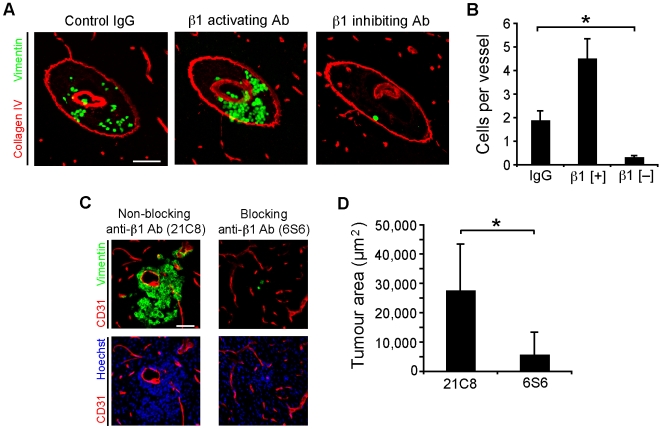
Adhesion to vascular basement membrane requires β1 integrin function.(A) MDA-MB-231 cells were tested for adhesion on slide-mounted human brain slices. Cells were plated in the presence of the indicated antibody and then washed after 2 h. Micrographs demonstrate adherent MDA-MB-231 cells (green) upon the same arteriole (red) in serial human brain sections under different treatment conditions (as indicated). Scale bar, 120 µm. (B) Adhesion to vessels was significantly attenuated with anti-β1 function blocking antibodies (*P<0.001, Kruskal-Wallis test with post-hoc Dunn's multiple comparisons test, tissue from 2 patients run in duplicate and repeated) and potentiated with an activating anti-β1 antibody. (C) MDA-MB-231 cells (vimentin+, green) were treated with β1 integrin subunit blocking or non-blocking antibodies prior to intraparenchymal injection in the brain of SCID mice. After 4 d, tumor colonies from animals in the non-blocking antibody condition (left panels) demonstrated vascular associated growth and invasion in contrast to the blocking condition (right panels). Horizontal sections. Scale bar, 60 µm. (D) Tumor cross sectional area was measured after 4 d growth with antibody treated cells showing significantly larger tumor area in the non-blocking condition (*P<0.05, Mann-Whitney U-test, n = 3–4 mice per treatment).